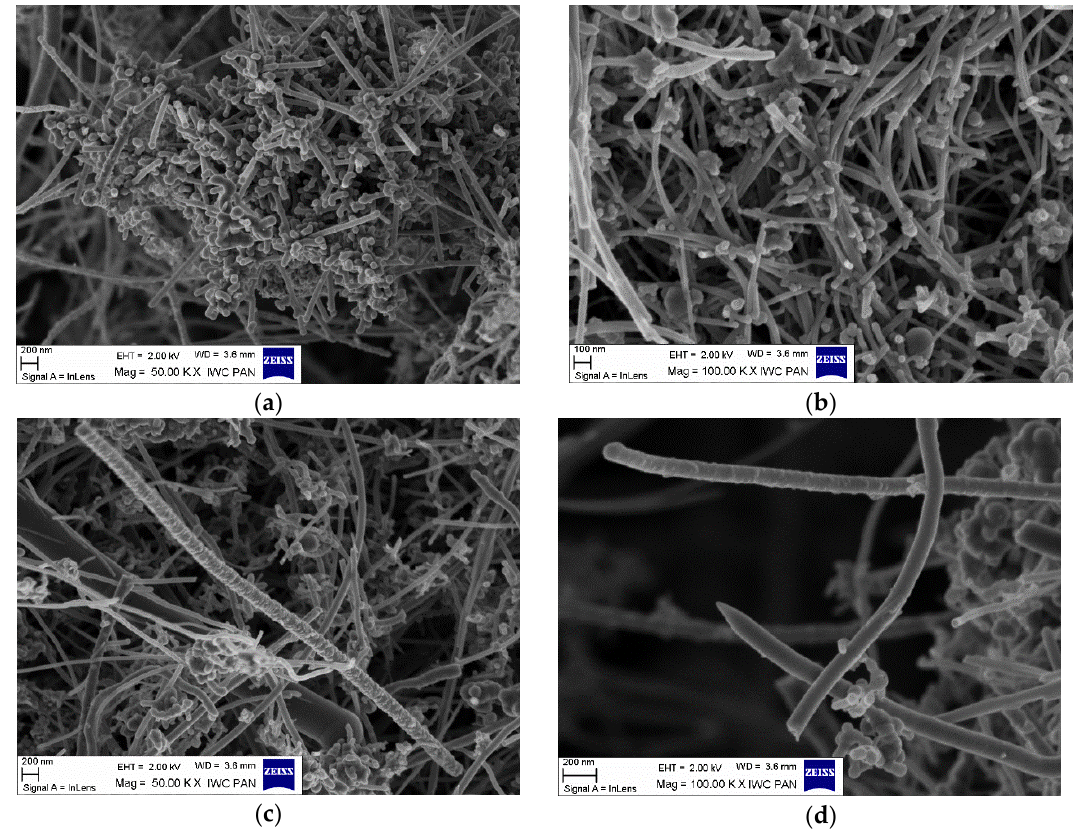
Figure 2. Scanning electron microscopy (SEM) images: ( a ), ( b ) untreated carbon nanofibers, and ( c ), ( d ) carbon nanofibers modified with APTS at 50 and 100 KX magnification.